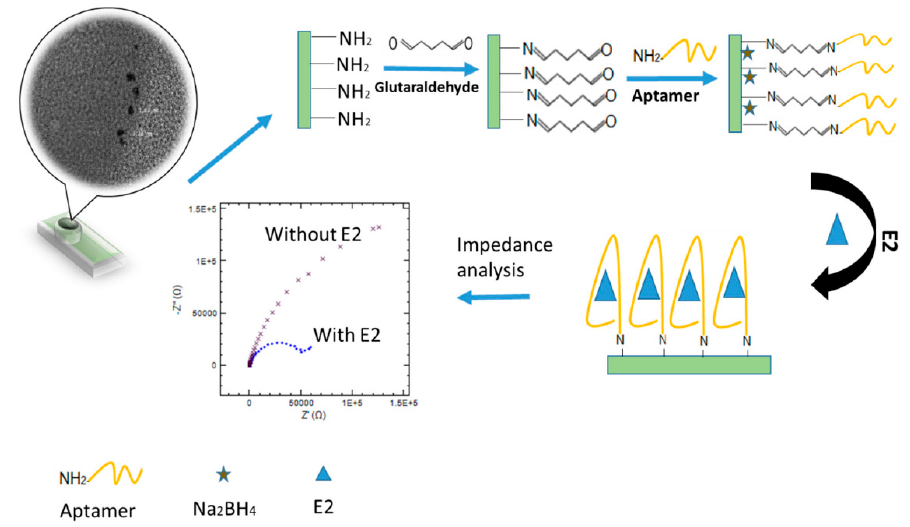
Figure 12. Schematic representation of the immobilization strategy and hybridization detection of 17b-estradiol on aptamer/CDs/SPCE [198].